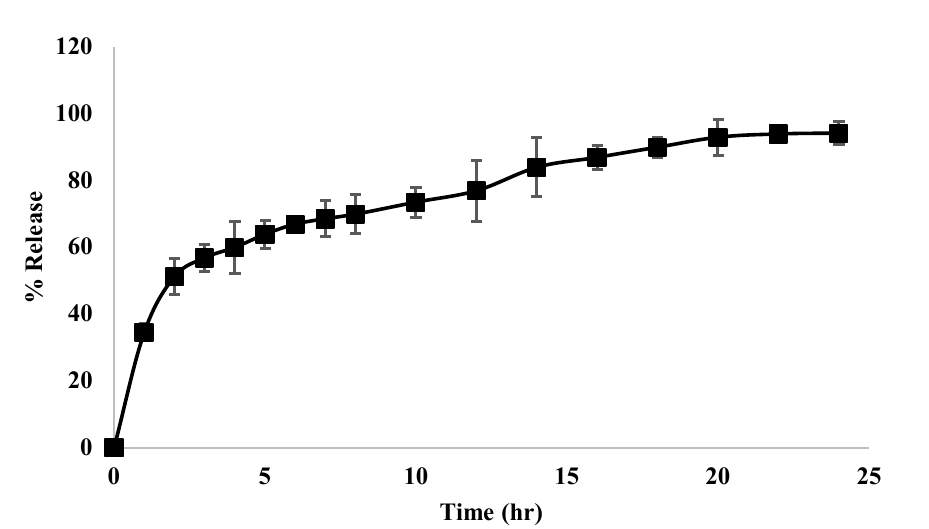
Figure 12. Release profile of TQ from TQ-loaded poly(ester amide) based on L-arginine nanoparticles (F3) for 24 h (means ± SD, n = 3). Table 7. The constant and coefficient of determination (R 2 ) and the “n” value for each mathemati- cal model.